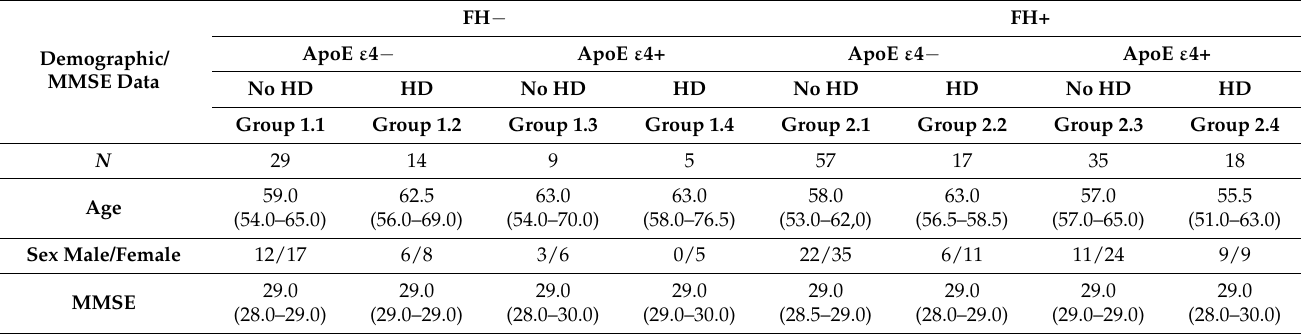
Table 2. Demographic data on the participants in the different study